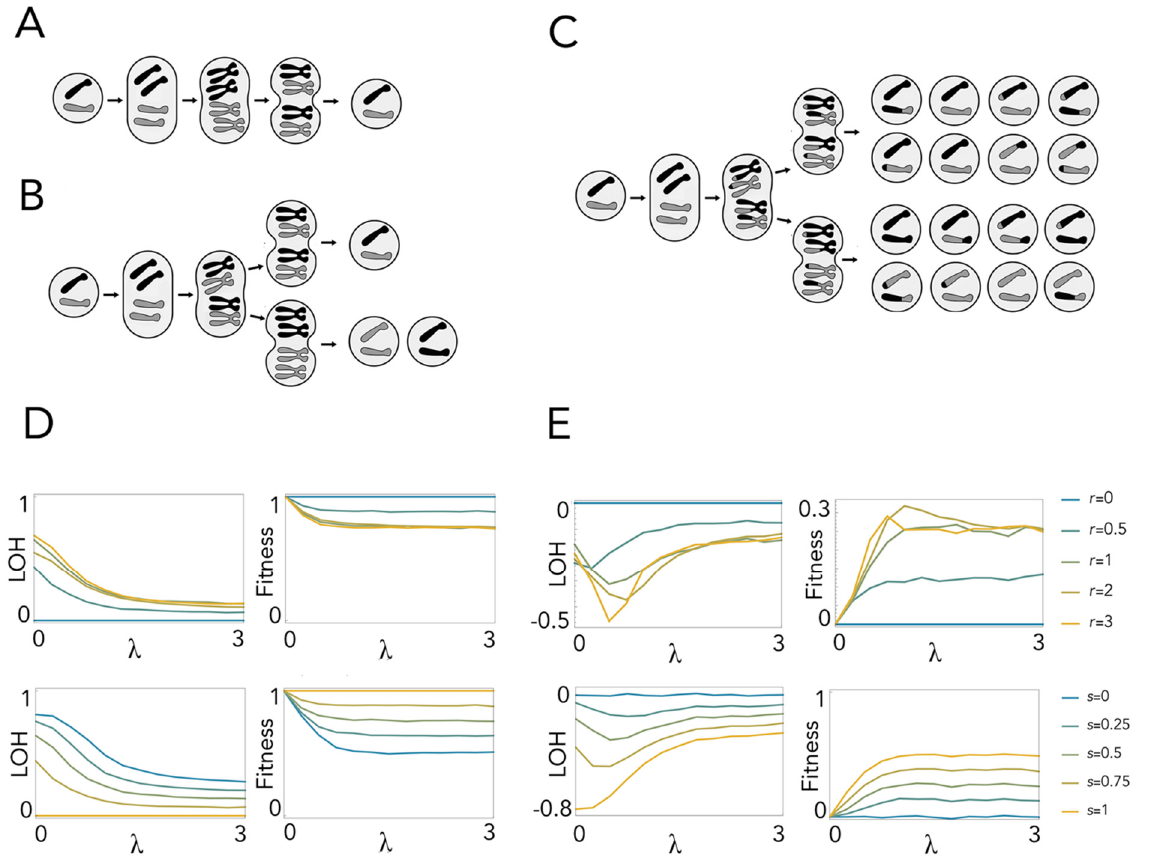
Figure 4. Loss of complementation in endomitosis. ( A ): Endomitosis with pairing of sister chromosomes: there is no LOH, with or without (shown here) recombination. ( B ): Endomitosis with pairing of non-sister chromosomes and no recombination: total LOH occurs in half of the daughter cells. ( C ): Endomitosis with pairing of non-sister chromosomes and recombination (one crossing-over event): partial LOH occurs in some of the daughter cells. ( D ): LOH and fitness at equilibrium for endomitosis. ( E ): Differences between endomitosis and diploid mitosis. LOH and fitness (for D ) or their difference (for E ) are plotted as a function of λ (the number of lethal equivalents) for different values of r (number of crossing-over events) with s = 0.5 (random pairing of chromosomes) and for different values of s (the probability of sister chromosome pairing) with r = 1 (one crossing-over event).